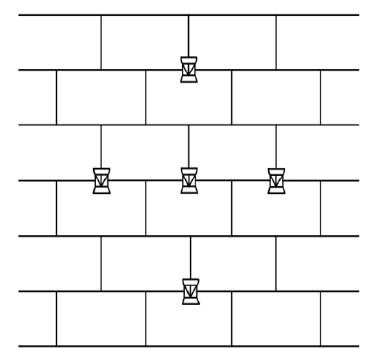
Figure 3. Layout scheme of observation signs